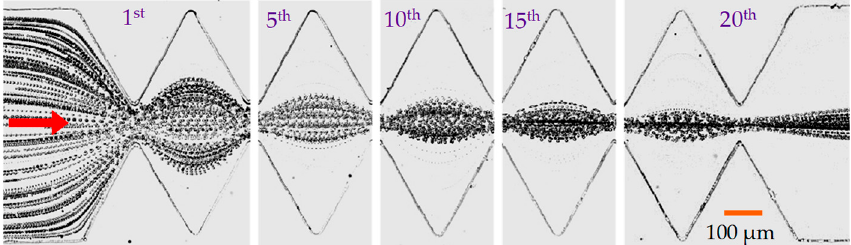
Figure 6. Top-view superimposed images demonstrating the development of yeast cell focusing at varying locations of the symmetric ratchet microchannel under a DC electric field of around 300 V/cm. The block arrow indicates the movement direction of cells.